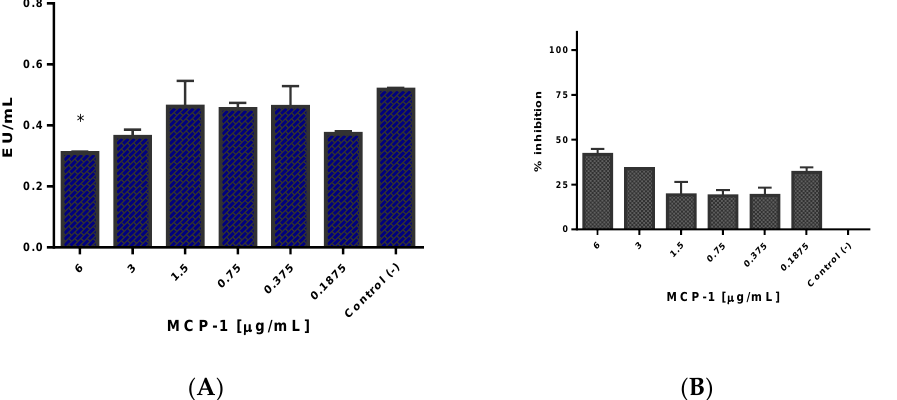
Figure 6. LPS from S . Typhimurium binds slightly to MCP − 1. Concentrations of 0.18 to 6 µg/mL of MCP − 1 were incubated with ≈0.5 EU/mL of S. Typhimurium LPS for 30 min ( n = 3). ( A ) Endotoxin units (EU) per mL with respect to MCP − 1 concentration; ( B ) Percentage of inhibition achieved by incubating the chemokine with LPS. Control ( − ): LPS + water. This figure shows the average of three independent experiments (* p < 0.05).